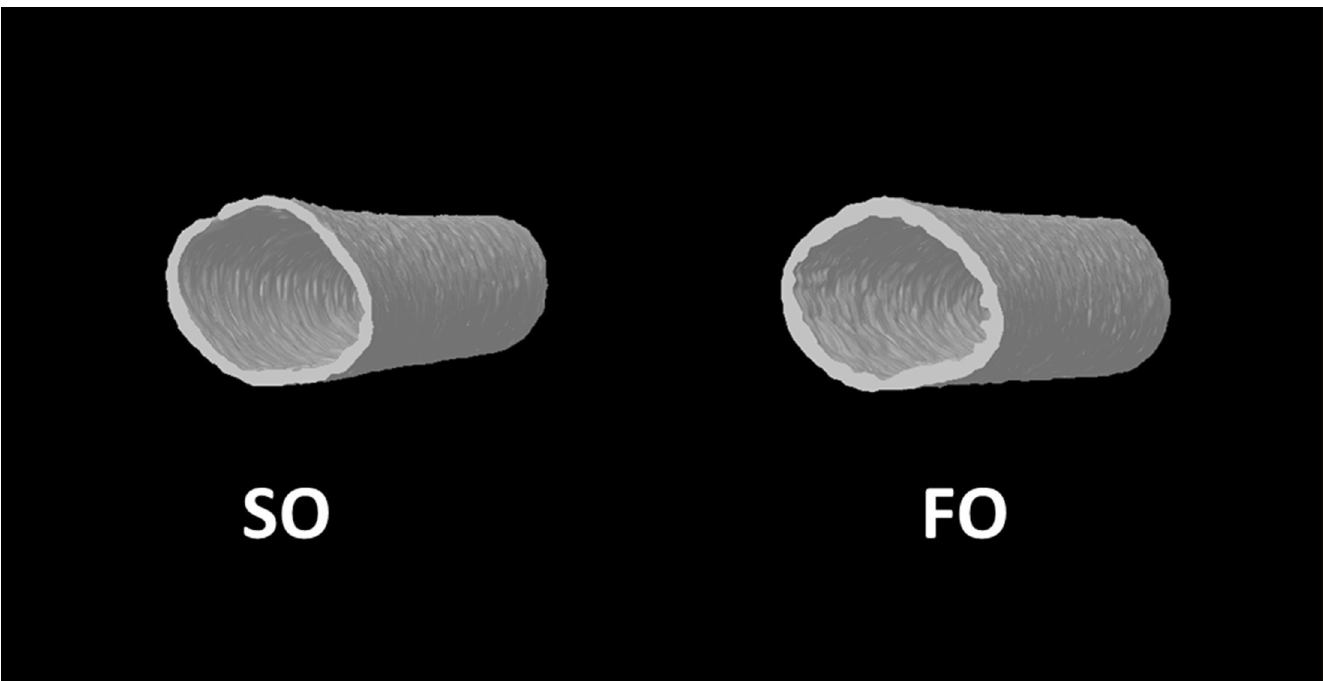
Fig 2. Reconstructed 2D structure of tibia diaphysis on day 18 embryo. Haversian artery was used as a landmark for region of interest (ROI) selection. The diaphysis bone traits were scanned and analyzed by μ CT.